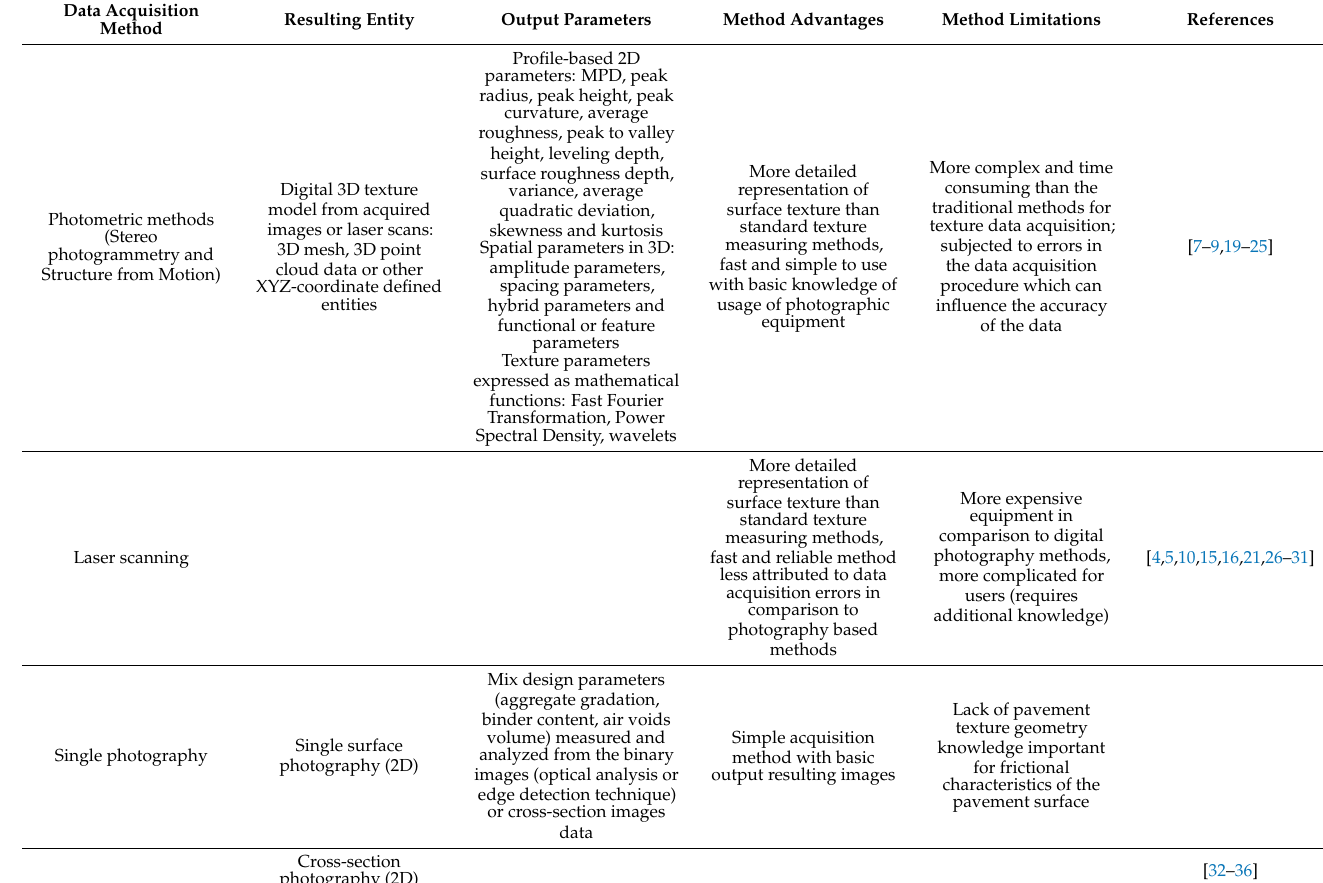
Table 2. An overview of image analysis methods for pavement texture